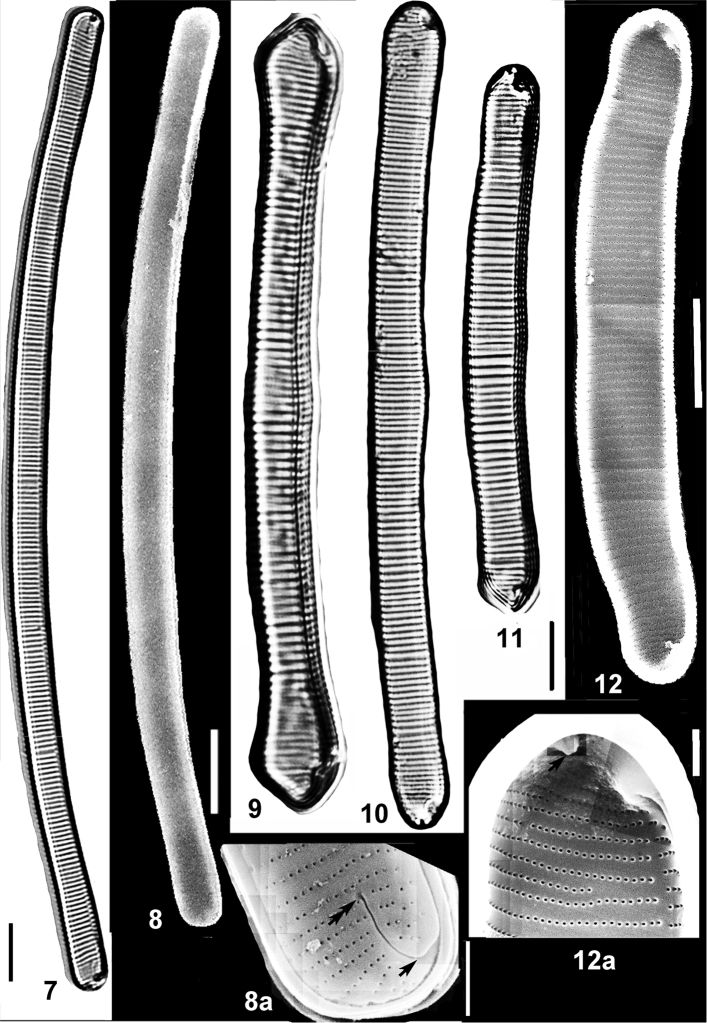
New and rare in Ukraine species of Eunotia Ehrenb. from the Cheremsky Nature Reserve. 7–8aEunotiajulma Lange-Bert. in Lange-Bertalot et al., arrow indicates distal end of raphe slit, double arrow – funnel-like lacuna, terminal fissure is between the arrows 9Eunotia sp. 1 (cf E.formica Ehrenb.) 10, 11Eunotiaformicina Lange-Bert. in Lange-Bertalot et al. 12, 12aEunotiajarensis Lange-Bert. et al., arrow indicates rimoportula. Figs 7, 9–11 LM 8, 8a outside valve surface 12, 12a inside valve surface, SEM. Scale bars: 10 µm (7–17); 3 µm (8a); 2 µm (12a).